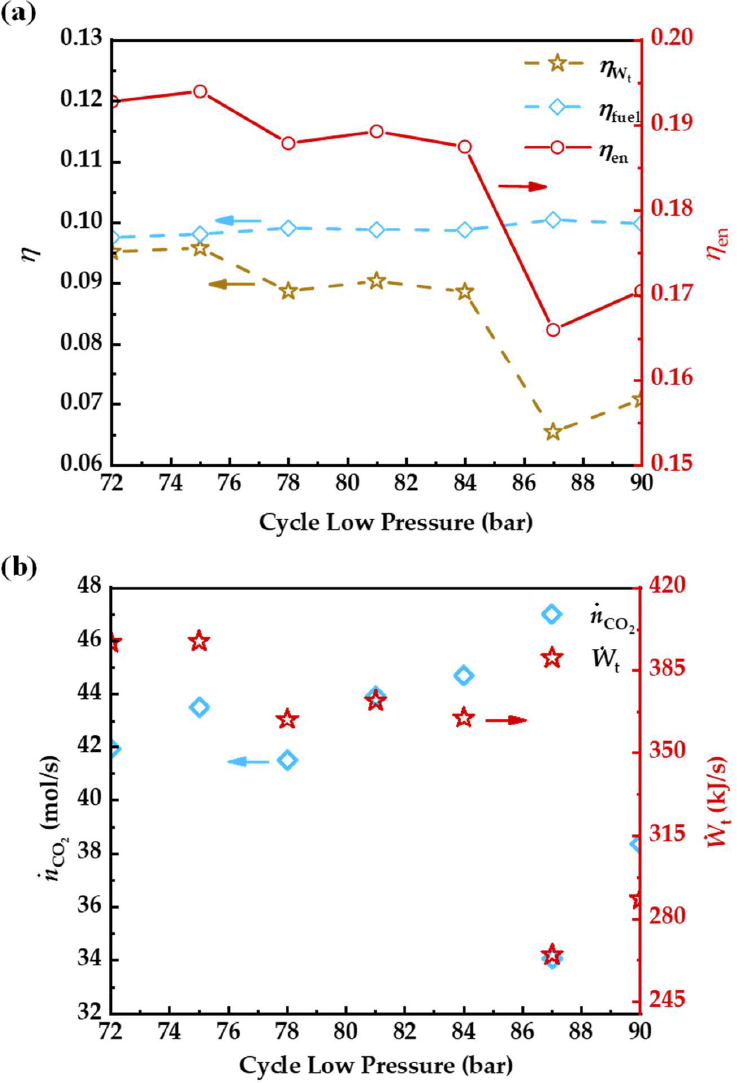
h , and η en ( P red = 10 − 4 bar), ( b ) influence of t . , , and h ( P red = 10 −4 bar), ( b ) influence of . n CO W t ( T red = 1900 K, T ox = 1300 K, P red = 10 − 4 bar, α = 0.95, ε gg = 0.9, and t W fu el en 2 ɺ ɺ n W and ( T red = 1900 K, T ox = 1300 K, P red = 10 −4 bar, α = 0.95, ε gg = 0.9, t 2 CO